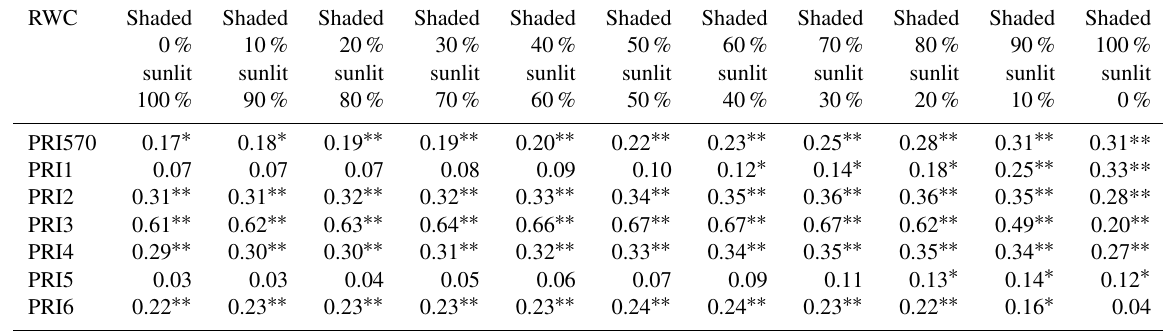
0.30 ∗∗ 0.30 ∗∗ 0.31 ∗∗ 0.32 ∗∗ 0.33 ∗∗ 0.34 ∗∗ 0.35 ∗∗ 0.35 ∗∗ 0.34 ∗∗ 0.27 ∗∗ 0.03 0.04 0.05 0.06 0.07 0.09 0.11 0.13 ∗ 0.14 ∗ 0.12 ∗ 0.23 ∗∗ 0.23 ∗∗ 0.23 ∗∗ 0.23 ∗∗ 0.24 ∗∗ 0.24 ∗∗ 0.23 ∗∗ 0.22 ∗∗ 0.16 ∗